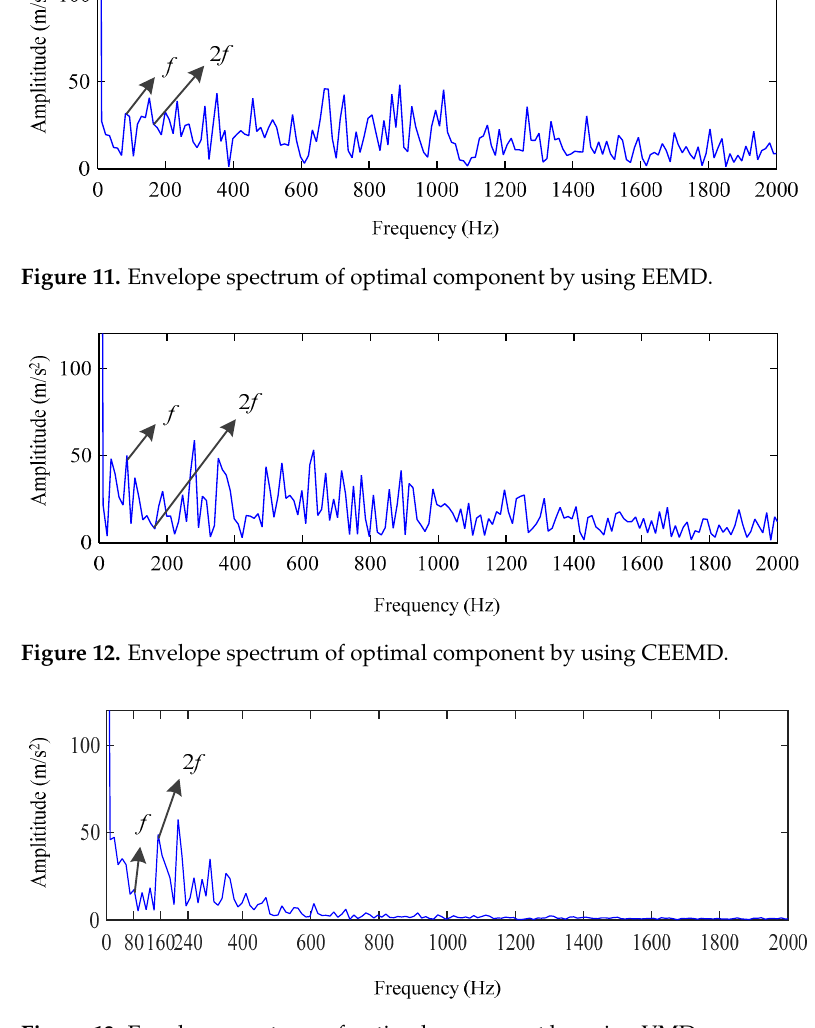
Figure 14. Changing curve of between the value of the objective function and the iteration num- ber. Figure 15. Envelope spectrum of optimal component by using IVMD. The IVMD method is implemented to analyze the simulation signal. The relationship between the value of the objective function and the number of evolutionary iterations is illustrated in Figure 14. It can be seen from Figure 14 that the frog of SFLA is only evolved to the fourth generation. The value of the optimal objective function is 0.8271. The optimal parameter combination (cid:4670)𝑘 𝛼(cid:4671) obtained by the optimization is [8, 1360]. The simulation